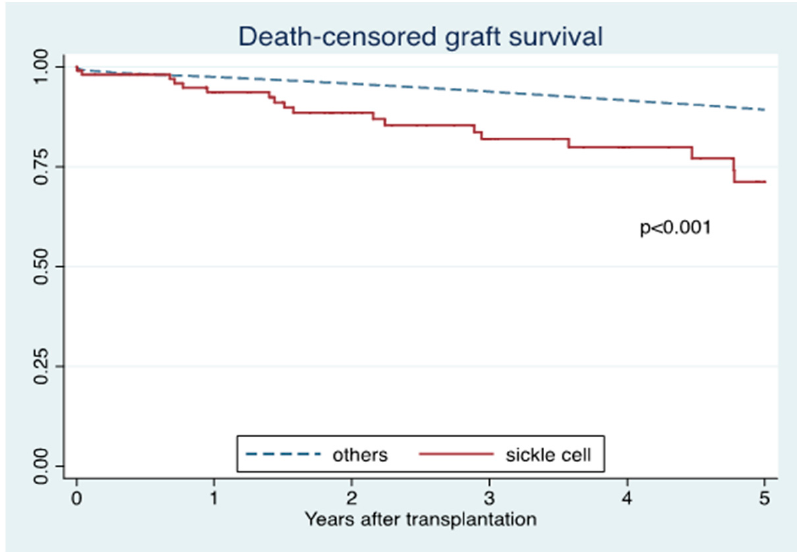
Figure 1. Death-censored graft survival of sickle cell disease compared to non-sickle cell disease recipients.